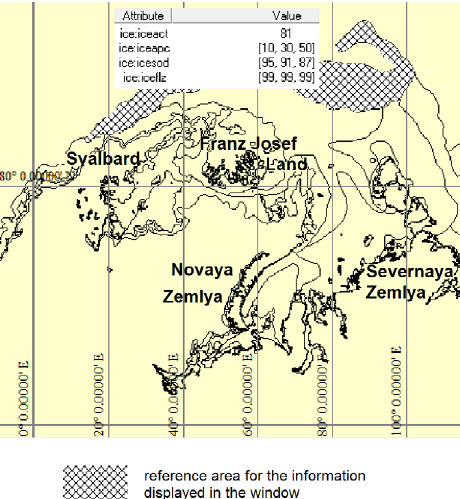
Fig. 8. General map of the Arctic Ocean of